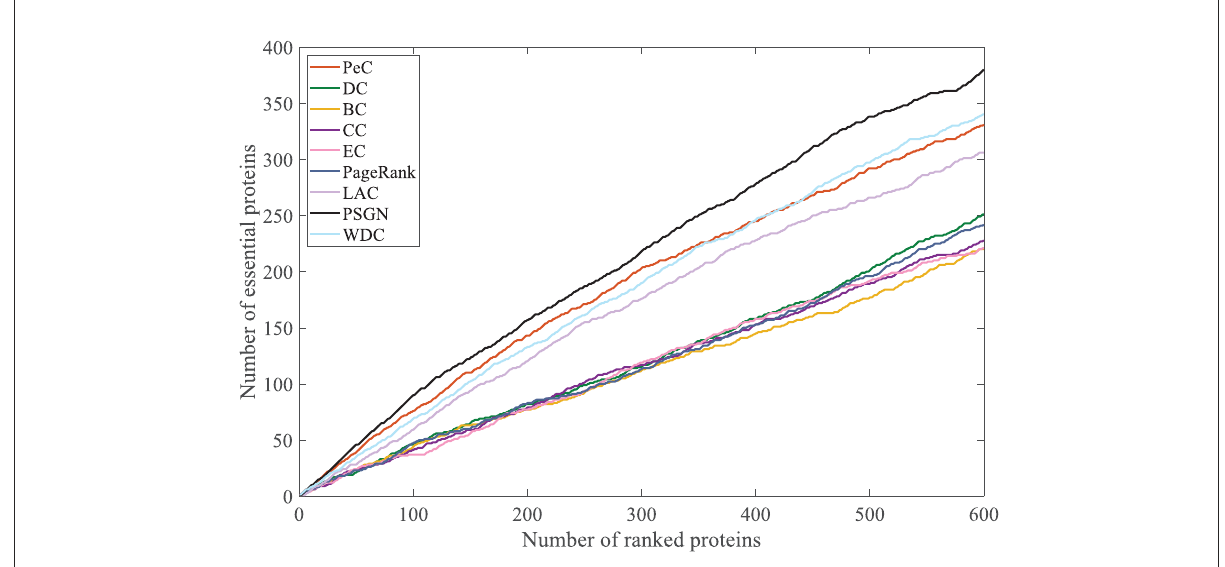
FIGURE6 Comparison of PSGN, BC, CC, DC, EC, LAC, PageRank, PeC, and WDC using Jackknife method.